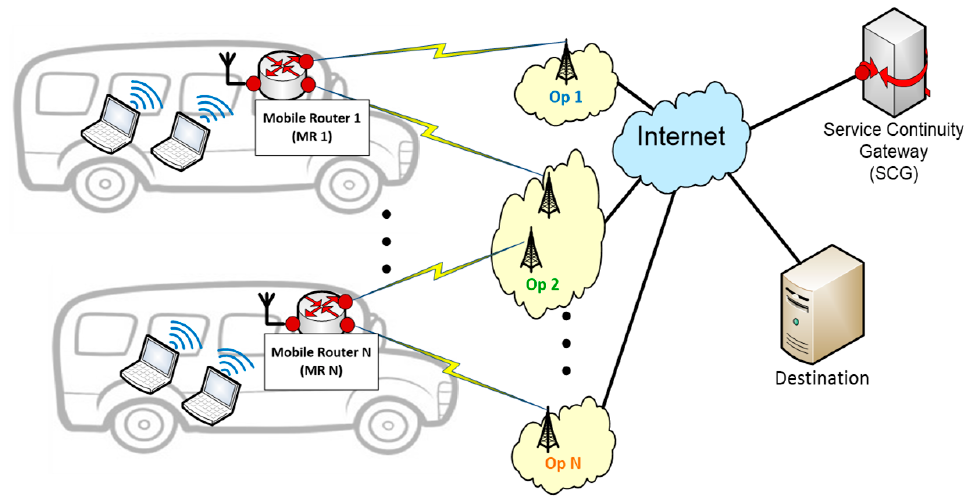
Figure 2. Heterogeneous network architecture that provides ubiquitous connectivity to public transportation vehicles.